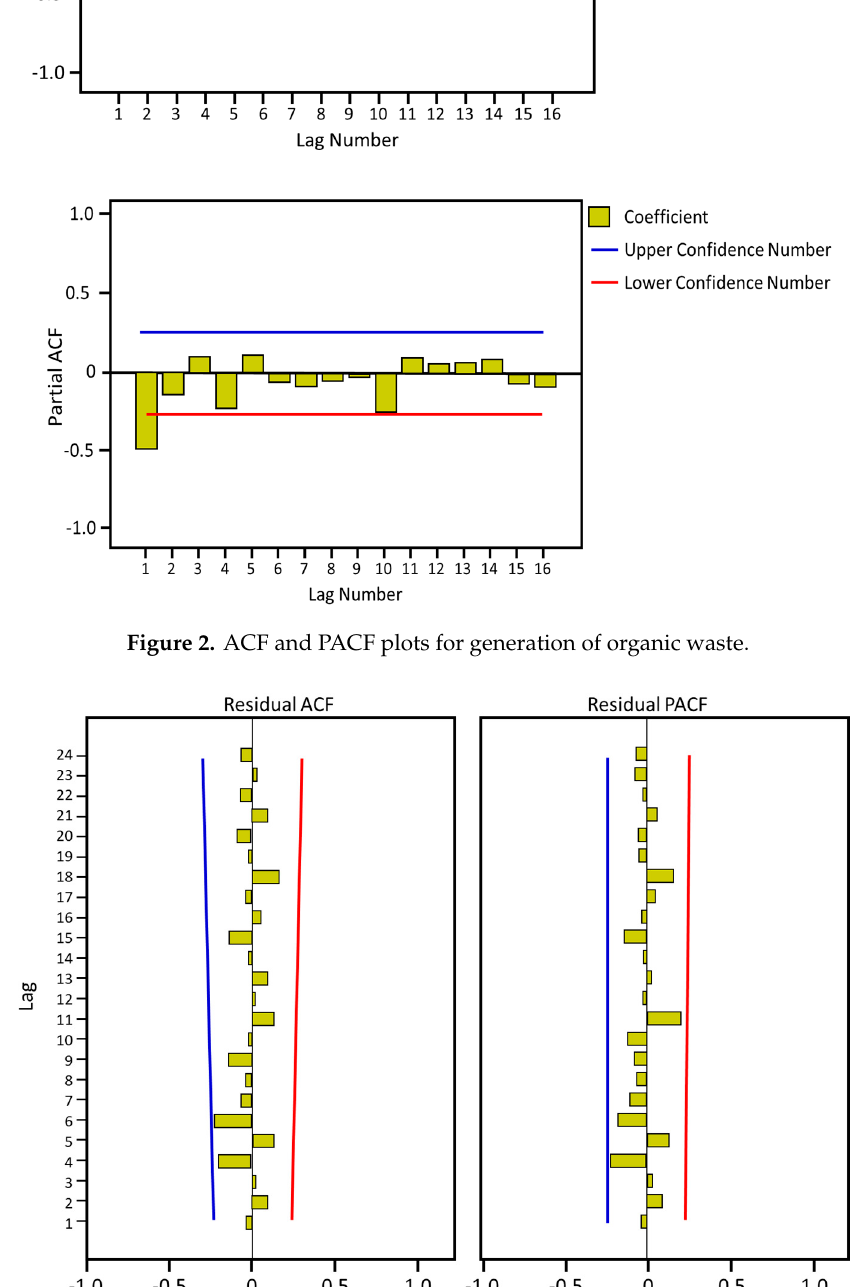
Figure 3. Residuals ACF and PACF plots for generation of organic waste.